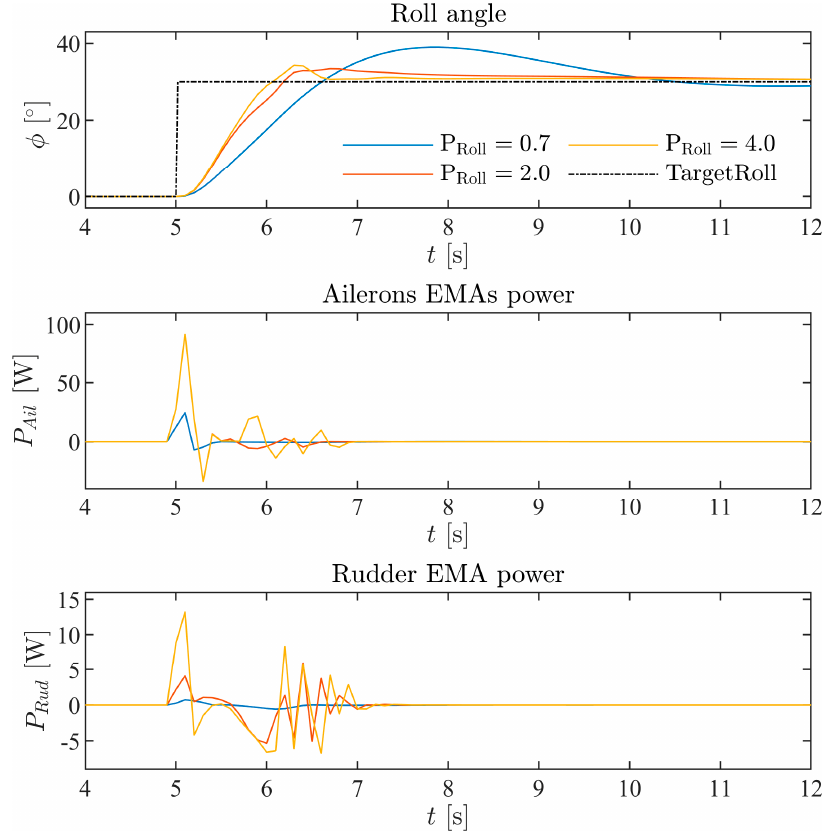
Figure 14. Roll control step responses at three proportional gains (0.7, 2.0, 4.0). The corresponding aileron and rudder EMA power consumption is also shown.